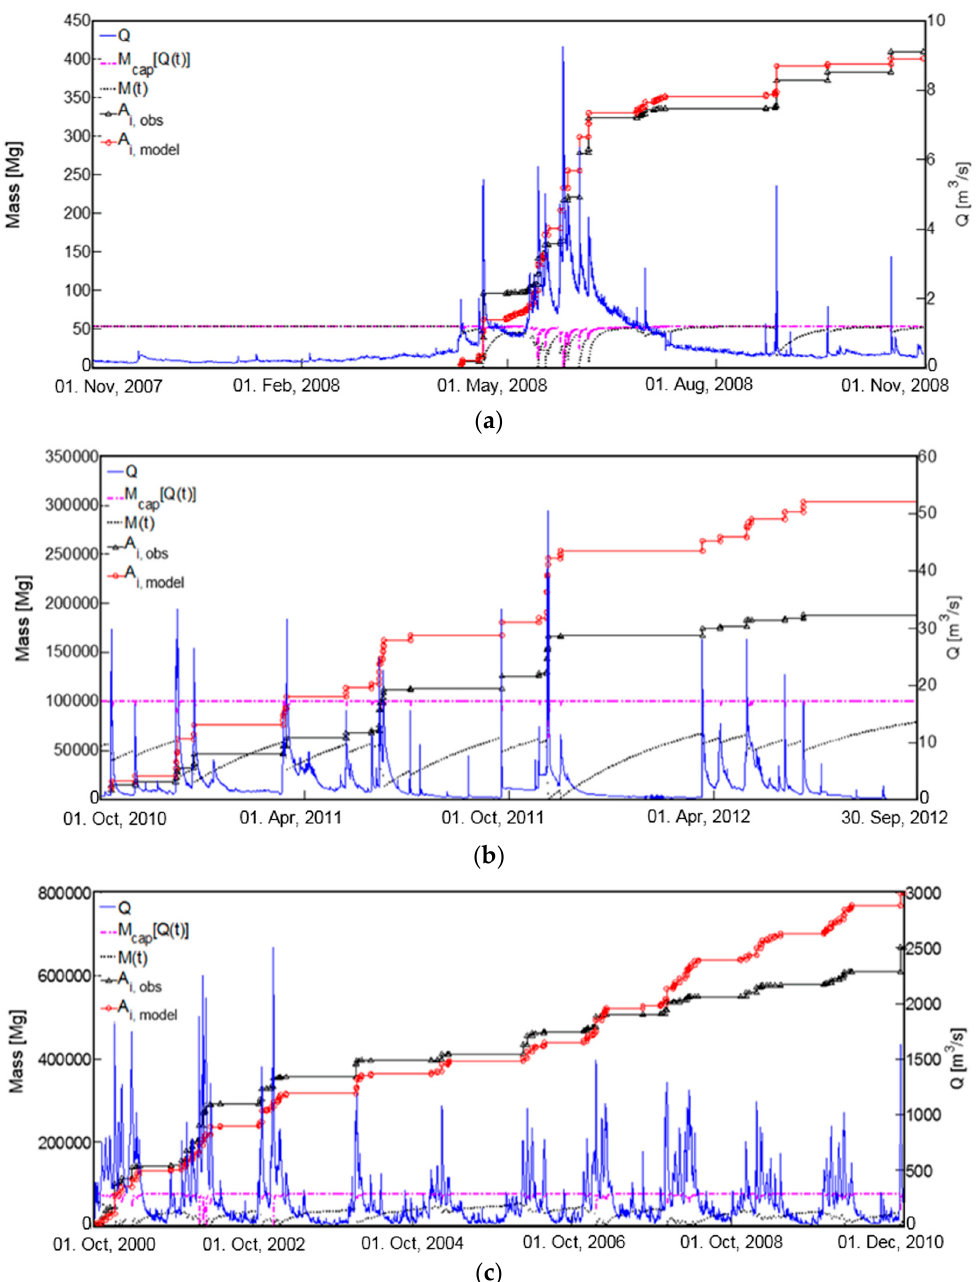
Figure 5. Model validation output for ( a ) the Ribera Salada from 1 November 2007 to 30 October 2008, ( b ) the Isabena from 1 October 2010 to 30 September 2012, and ( c ) the Meuse River from 1 October 2000 to 30 November 2010. The dashed magenta line represents the storage capacity of the sediment bed for fine sediments, M cap [Q(t)], and the dotted black line represents the mass of fine sediments stored in the sediment bed, M(t). The black line with triangles represents the observed cumulative mass of fine sediments released from the sediment bed by the first i flood events (A i,obs ) and the red line with circles represents the modeled cumulative mass of sediments released for the first i flood events (A i,model